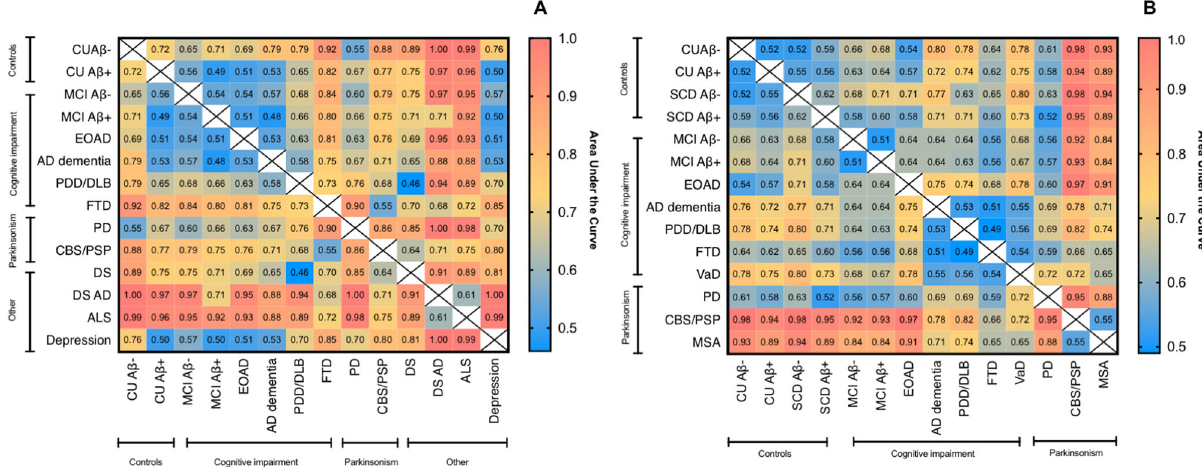
Fig. 3 The diagnsotic accuracy of plasma NfL in neurodegenerative disorders. Heatmaps to demonstrate the accuracy (AUC) of plasma NfL to distinguish CU and neurodegenerative disorders in the KCL ( A ) and Lund ( B ) cohorts. Heatmaps tables that demonstrate sensitivity, speci fi city, and 95% CI of AUC displayed in the Supplementary Tables 4 – 5 and Supplementary Fig. 4. AD Alzheimer ’ s disease, ALS amyotrophic lateral sclerosis, CU